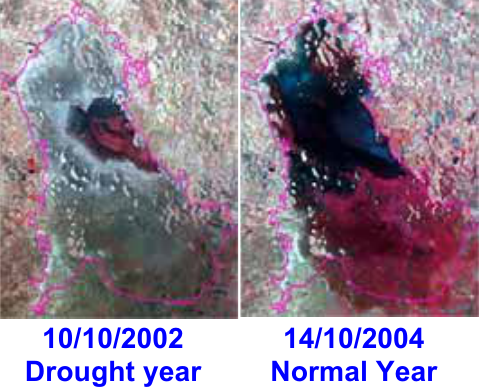
Figure 3: IRS LISS III FCC of Nalsarovar Lake area showing status of open-water and emergent vegetation areas during post-monsoon month of October in a drought year (2002) and a normal year (2003)